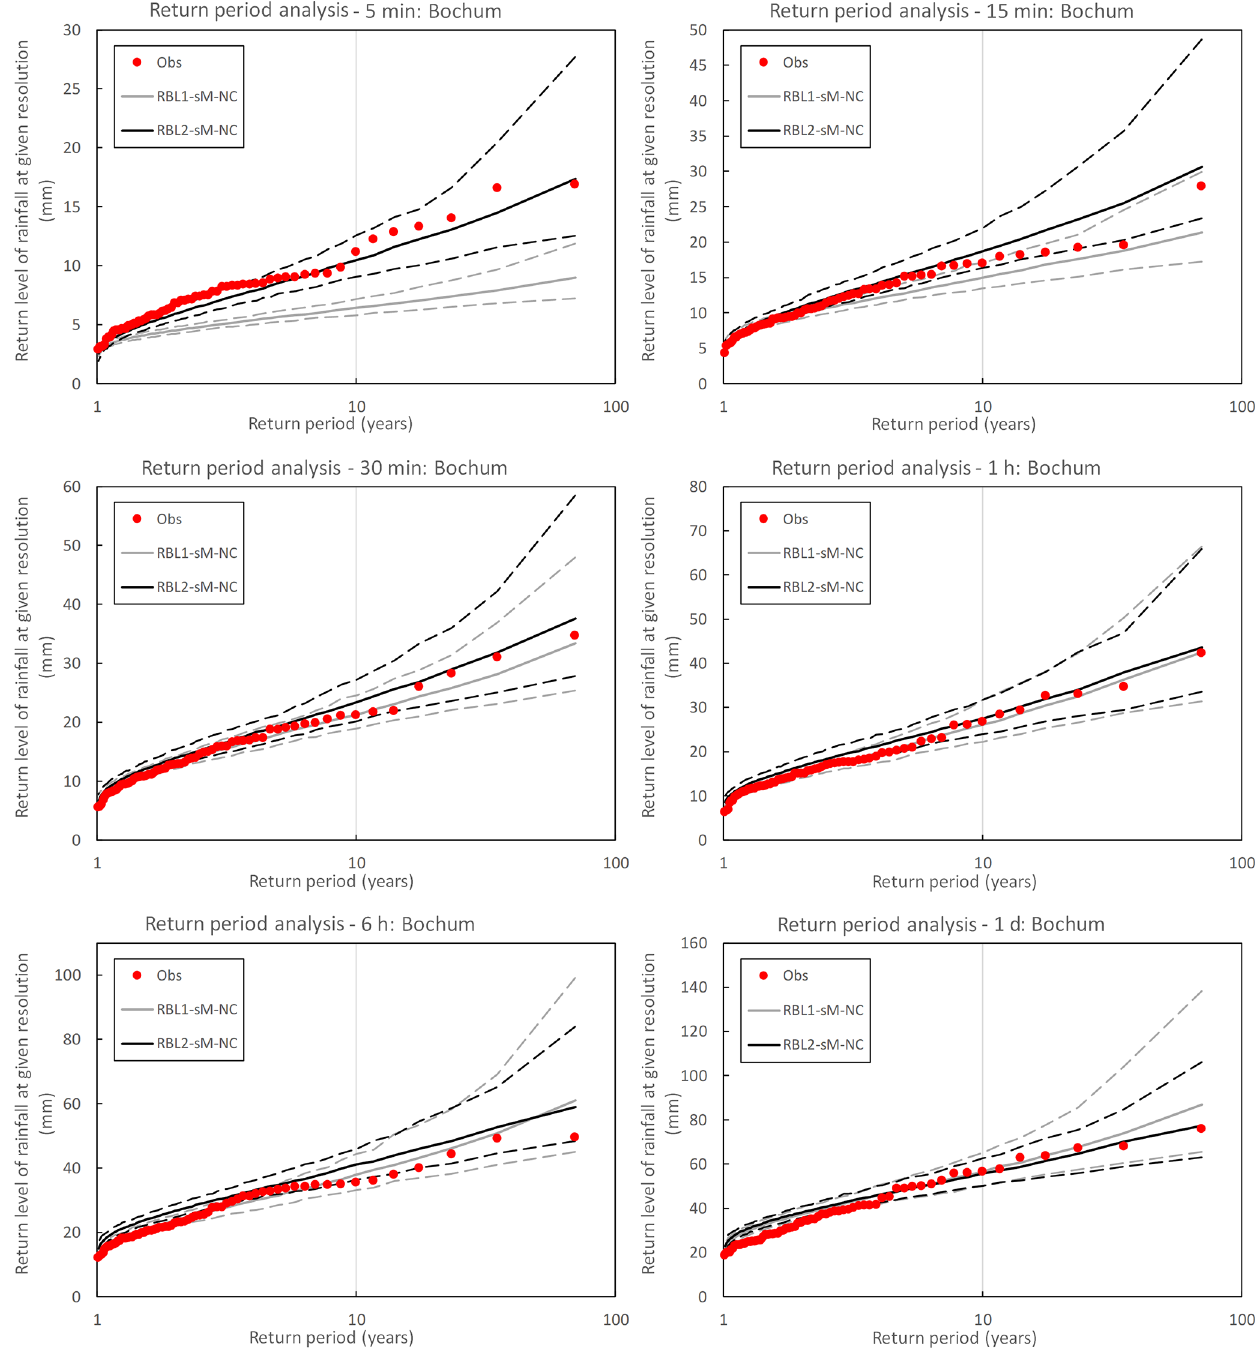
Figure 12. Observed (round markers) and simulated (lines) return levels of rainfall at multiple timescales at Bochum. The simulated return level is sampled from the RBL1 (grey lines) and RBL2 (black lines) models fitted with the new solution spaces of α . The median, 95th and 5th percentile return levels obtained from 250 simulations, each of 69 years, are plotted with solid and dashed lines,